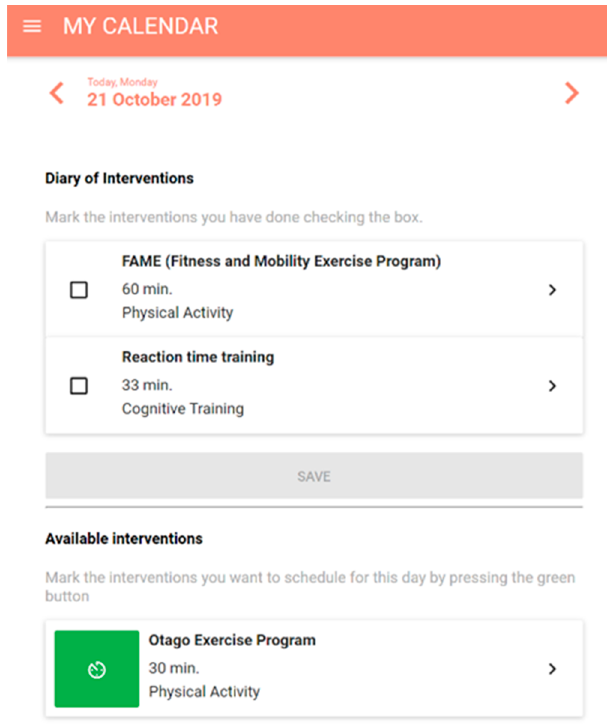
Figure 8. My-Calendar interface.